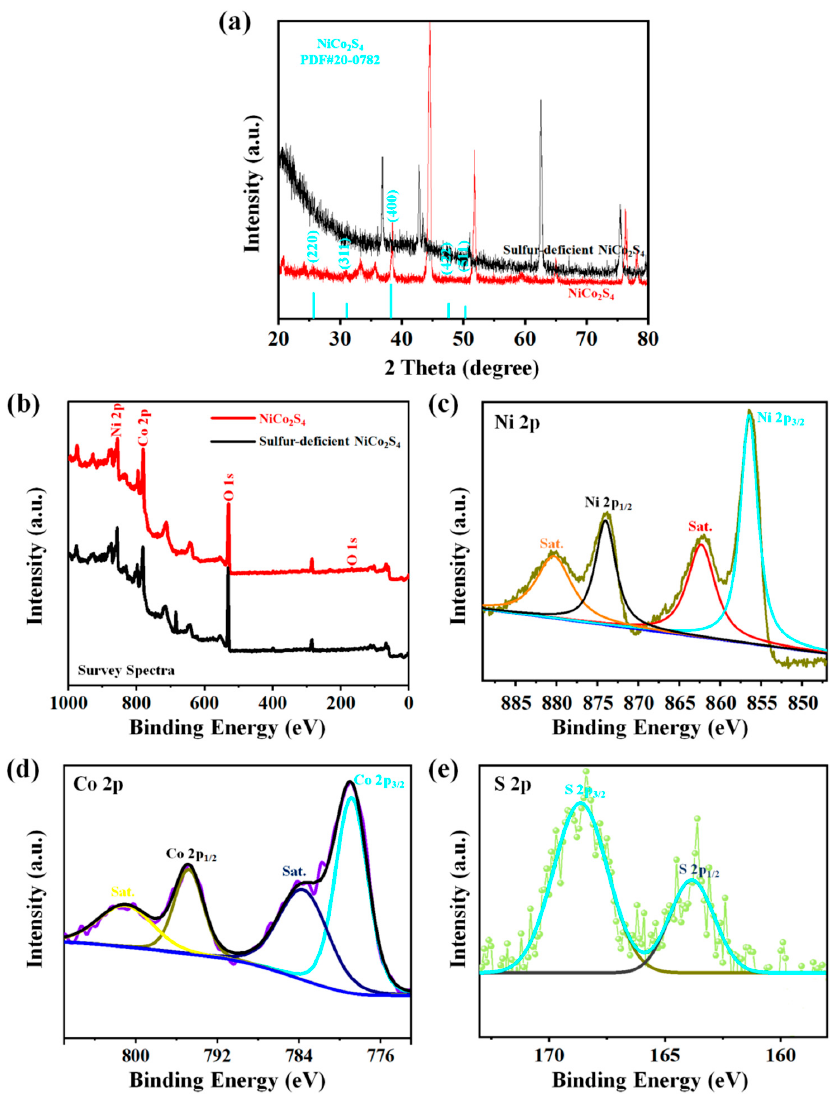
Figure 4. ( a ) XRD patterns of pure NiCo 2 S 4 nanoparticles electrode and sulfur-deficient NiCo 2 S 4 nanosheet composites. ( b ) XPS survey spectra, and ( c – e ) Ni 2p, Co 2p, and S 2p spectra for sulfur-deficient NiCo 2 S 4 nanosheet composites.